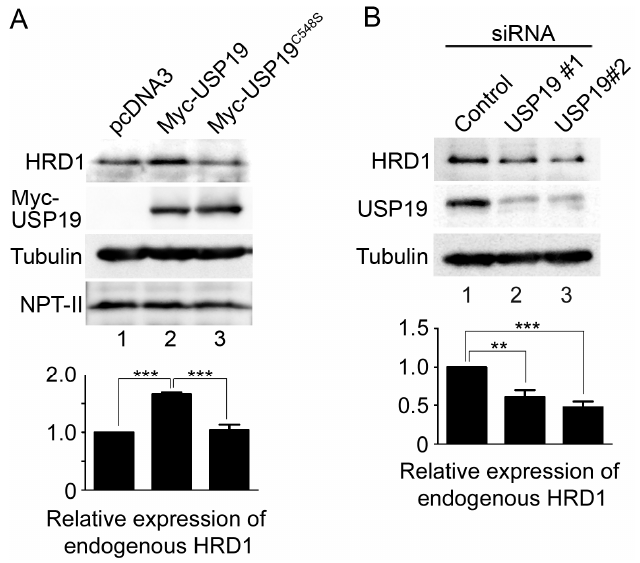
Figure 3. Both overexpression and knockdown of USP19 affect endogenous HRD1 expression. ( A ) The 293T cells were transfected with either a pcDNA3 vector (lane 1), Myc-USP19 (lane 2) or Myc-USP19 C548S (lane 3). Whole cell lysates (20 μ g of protein) were analyzed by Western blotting with antibodies against HRD1 ( top panel), Myc ( second top panel), α -tubulin ( third top panel) and NPT II ( bottom panel); ( B ) the 293T cells were transfected with control siRNA (lane 1) or USP19 -specific siRNA duplexes (lanes 2 and 3). Three days after transfection, whole cell lysates (30 μ g of protein) were analyzed by Western blotting with antibodies against HRD1 ( top panel), USP19 ( middle panel) and α -tubulin ( bottom panel). The bar graphs show the relative expression of HRD1 normalized to α -tubulin expression from at least three independent experiments (mean ± SEM). **, *** statistically significant (one-way ANOVA, post-hoc test, ** p < 0.01 and *** p < 0.001, respectively).